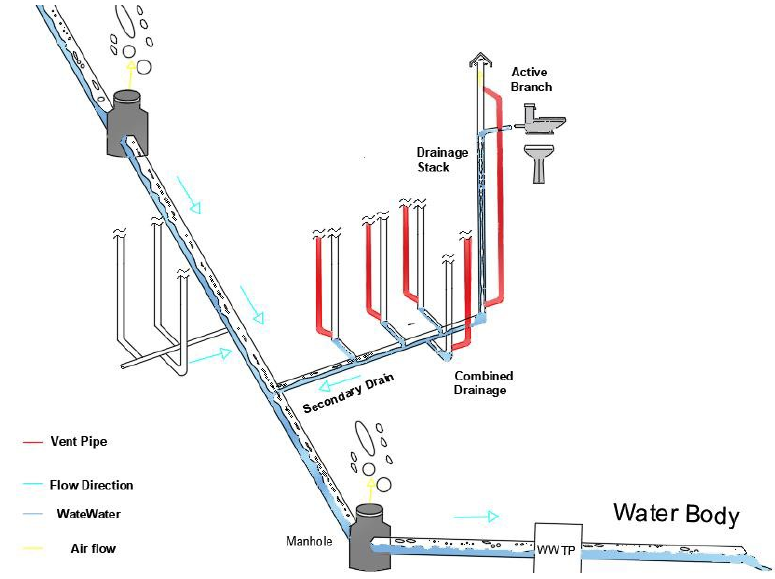
Figure 4. Wastewater collection system .